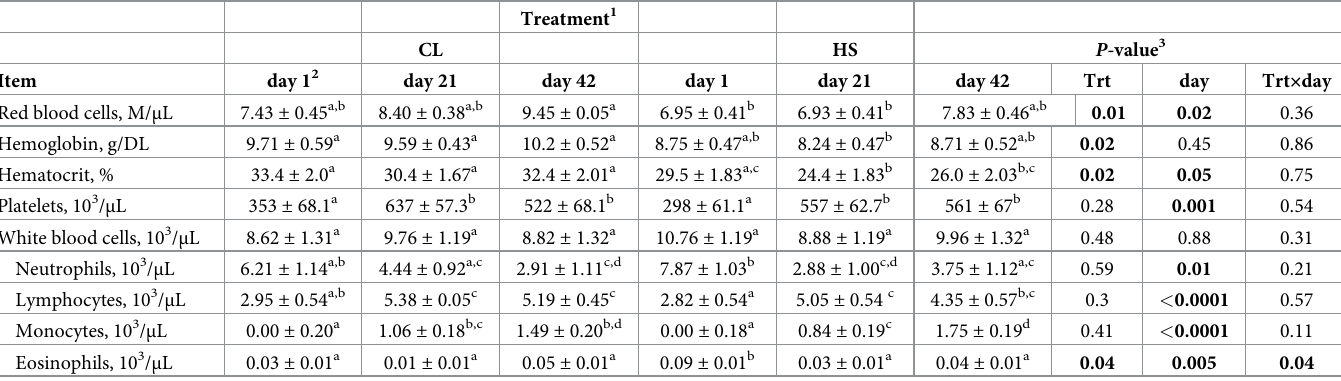
Table 1. Complete blood counts of Holstein dairy calves at 1, 21 and 42 days of age.